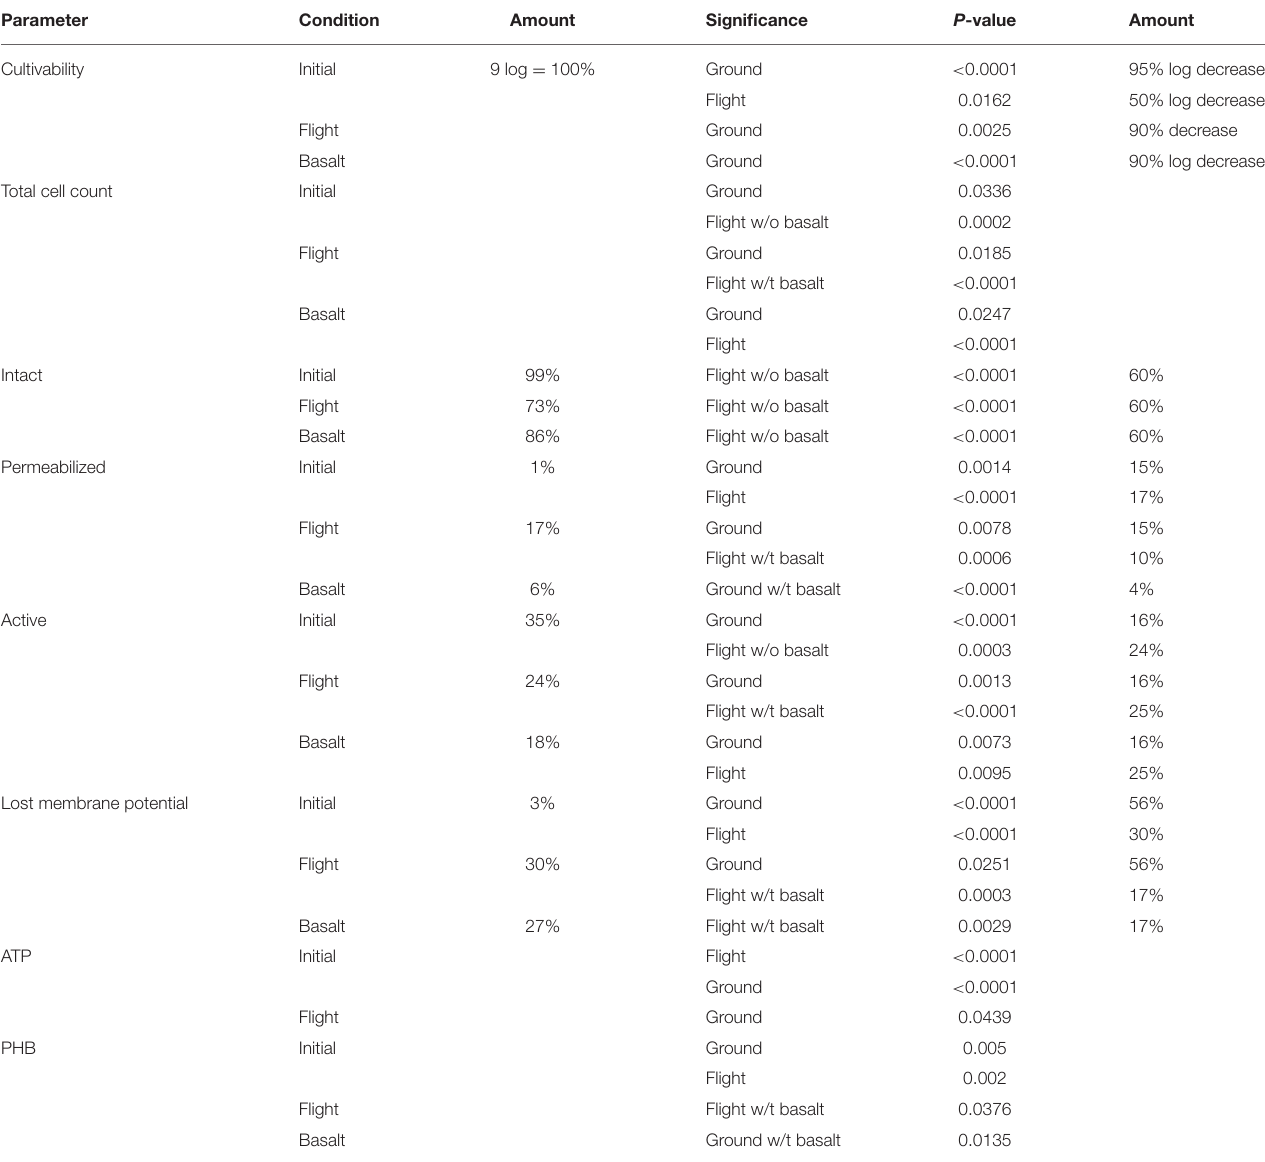
TABLE 4 | Summarizing table of the results for the different parameters of the planktonic cell fraction as well as the statistical significance ( P -value), cultivability decrease and percentages of the population measured with flow cytometry.